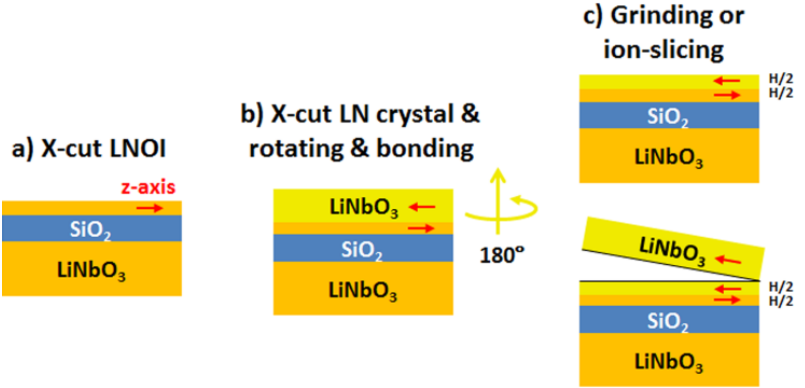
Figure 6. Suggested flow chart for fabrication of alternatively-layered LNOI wafer. Optic axes are indicated by red arrows. All the linear optical properties are identical with ordinary LNOI